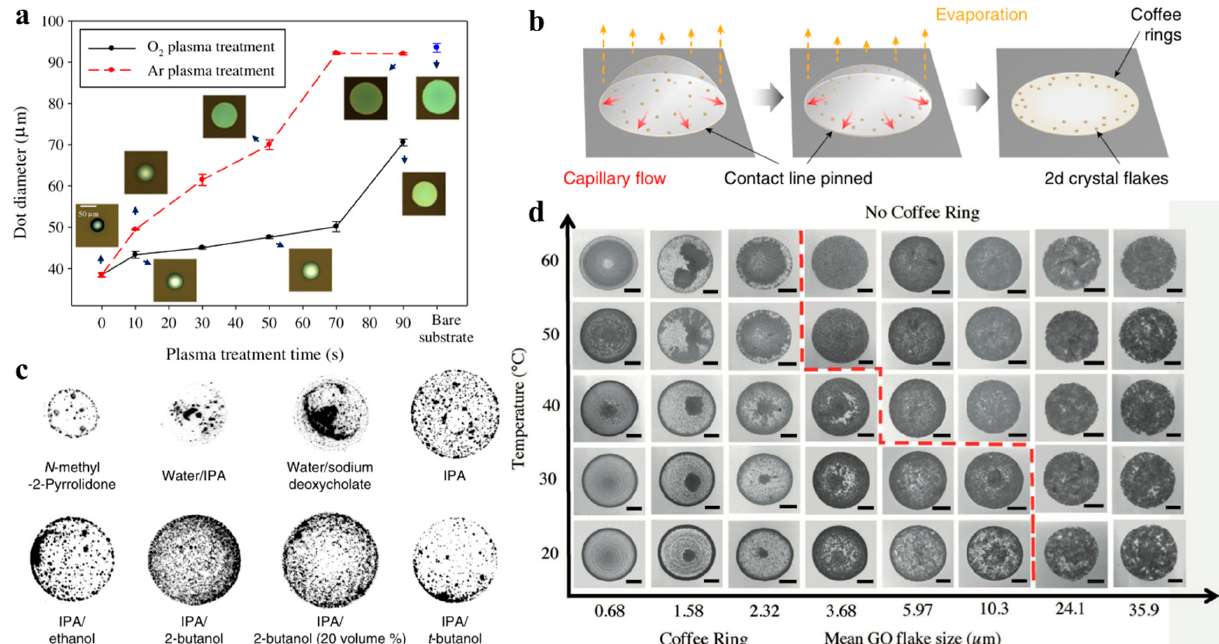
Figure 7. ( a ) Variation in inkjet-printed dot diameter as a function of O 2 or Ar plasma treatment time. Reprinted with permission from Ref. [62] . Copyright 2013 Elsevier. ( b ) Schematic drying process showing CRE formation; ( c ) inverted optical micrographs of dried inkjet-printed droplets on clean glass: common solution-processed 2D crystal dispersions. Formulated inks via solvent exchange in IPA or binary solvents of IPA/ethanol (10 volume %), IPA/2-butanol (10 and 20 volume %), and IPA/t-butanol (10 volume %). Reprinted with permission from Ref. [23] , Copyright 2020 American Association for the Advancement of Science. ( d ) SEM image map for printed droplets in rows with increasing substrate temperature and in columns from left to right with increasing mean GO flake size. The dotted line indicates the parameter space where the coffee ring is fully suppressed. All scale bars are 100 μ m. Reprinted with permission from Ref. [42] . Copyright 2017 John Wiley and Sons.